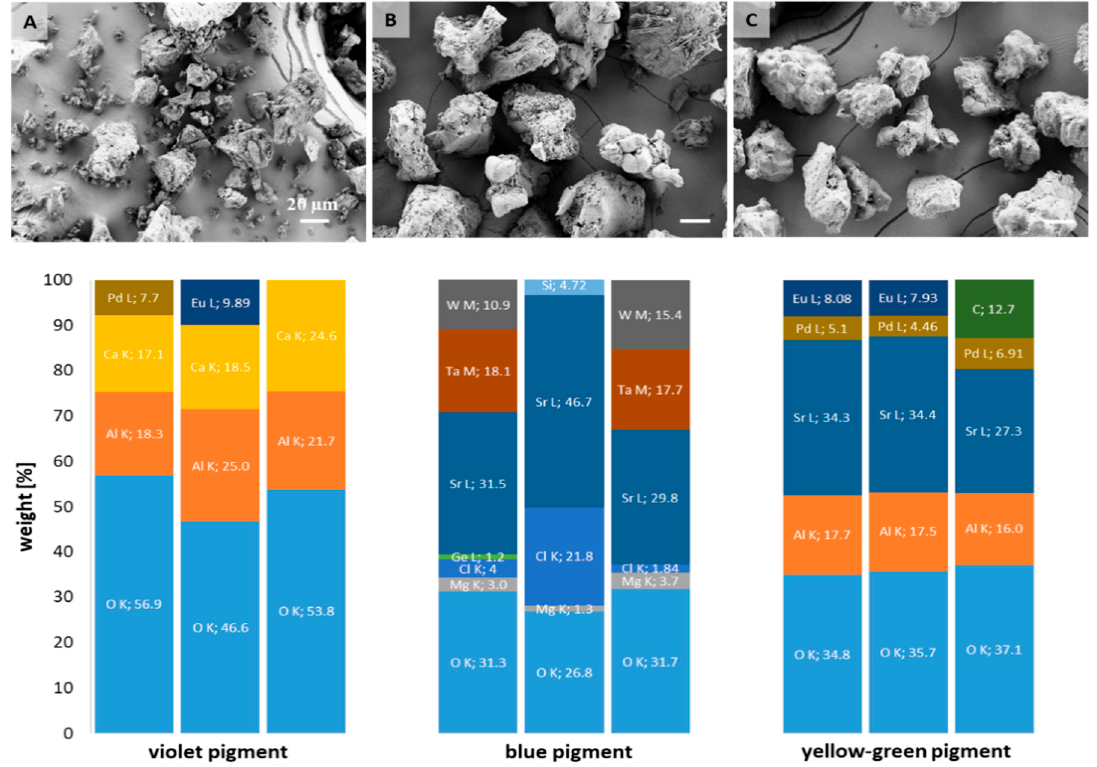
Figure 1. Scanning electron microscope (SEM) images of violet ( A ), blue ( B ) and yellow-green pigment ( C ) at 1000× magnification, with elemental (EDX) analysis (wt %) extracted from 3 images of each pigment, presented below the respective pigment. The scale bar corresponds to 20 µm in each micrograph.